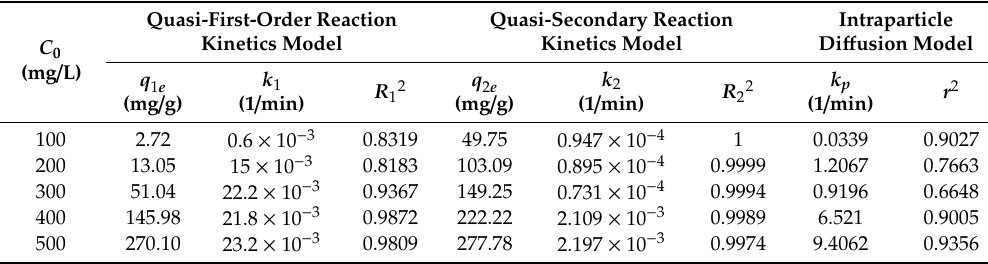
Table 5. Effect of initial dye concentration on the adsorption kinetics model. The adsorption test was conducted with 2 g/L of modified sepiolite under an oscillation rate of 170 r/min and a temperature of 25 °C.